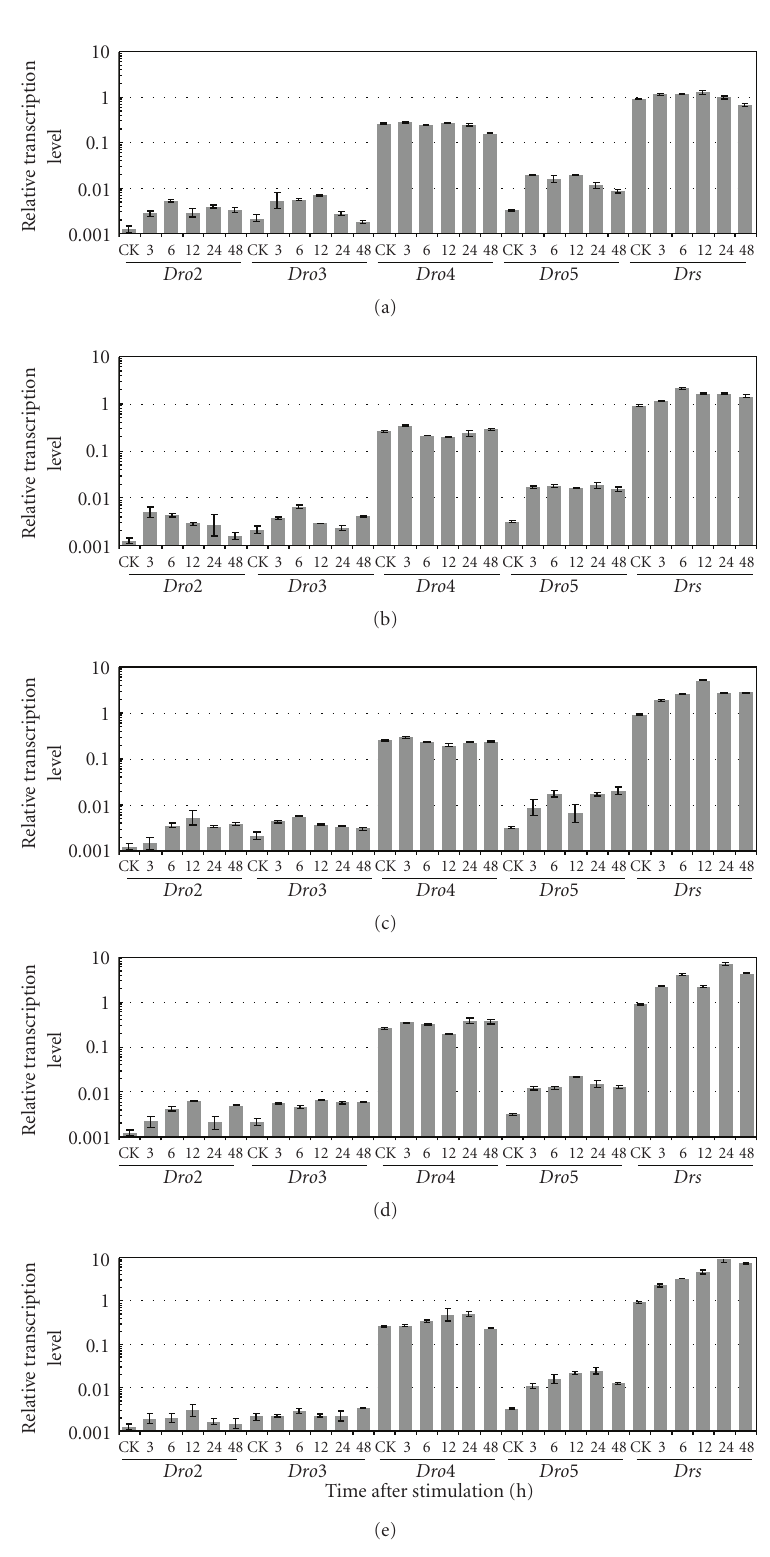
Figure 1: The transcription activity of drosomycin gene family in D. melanogaster stimulated by microbe-free injury and various microorganisms. Quantitative real time RT-PCR was performed for the detection of the expression levels of drosomycin genes in wild- type Oregon-R flies with SYBR Green. The expression levels of drosomycin genes were normalized to rp49 in the samples. The experiments were done in triplicate and the error bars represented standard deviation. CK: native flies. (a) The 2-day-old adult flies were pricked by a sterile needle (microbe-free injury). (b) to (e) The 2-day-old adult flies were infected with E. coli K 12 D 31 , Staphylococcus aureus, Fusarium oxysporum, and Beauveria bassiana,